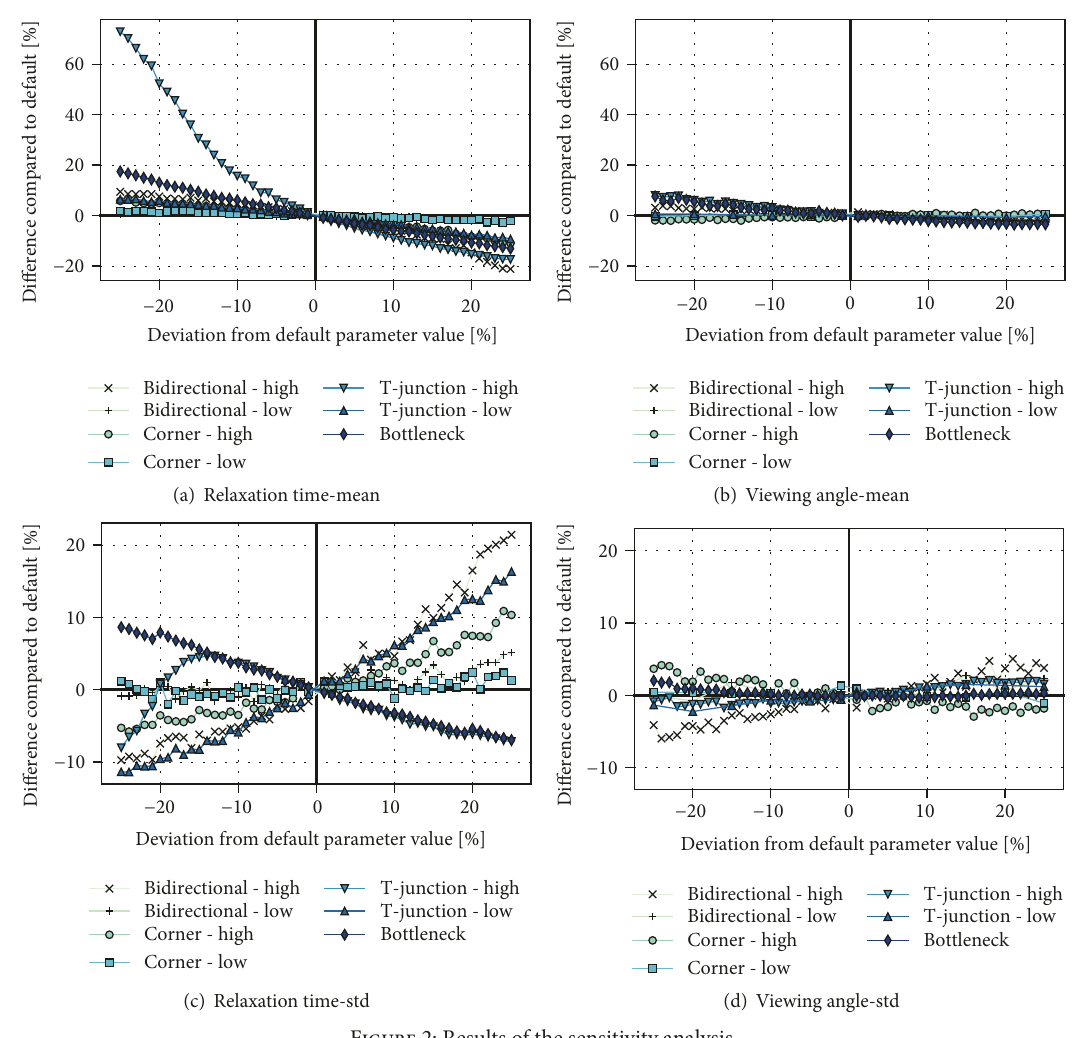
Figure 2: Results of the sensitivity